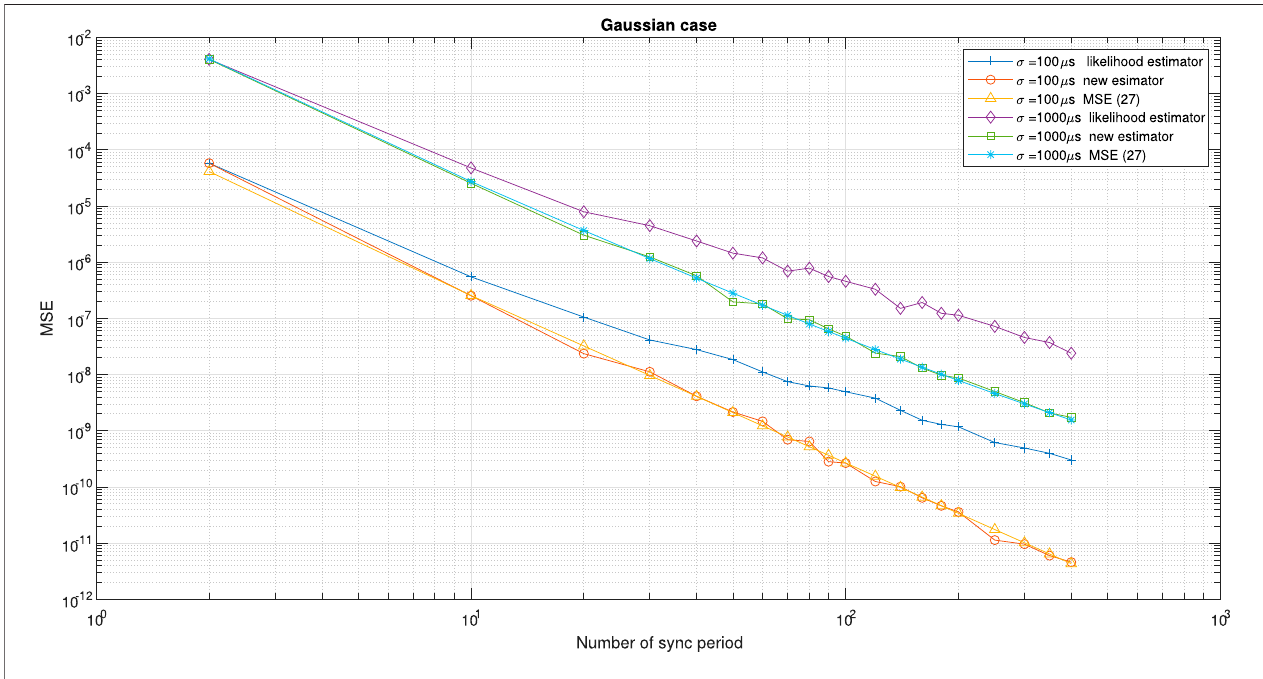
FIGURE 6 | Performance comparison between the new clock skew estimator Eq. 3 with the clock skew estimator of Noh et al. [34]denoted here as the likelihood estimator. In addition, we have the simulated performance results for our new proposed expression for the MSE Eq. 27 for the white-Gaussian case. α (cid:1) 50 ppm , Q (cid:1) 5 ms , T syn (cid:1) 15 . 6 ms ( 64 packet results were obtained for 100 Monte-Carlo